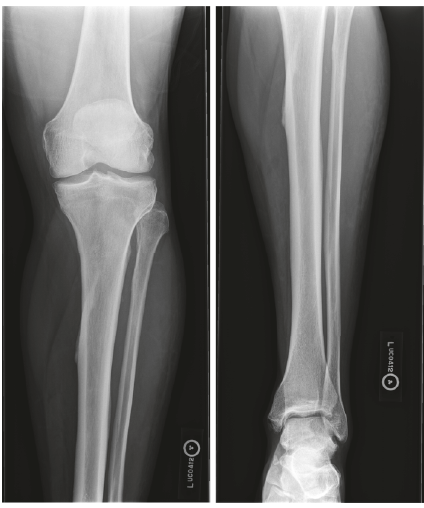
Figure 1: Initial X-ray of the left tibia and fibula is displayed. There is mild tibial plafond spurring. No other acute abnormalities are identified.